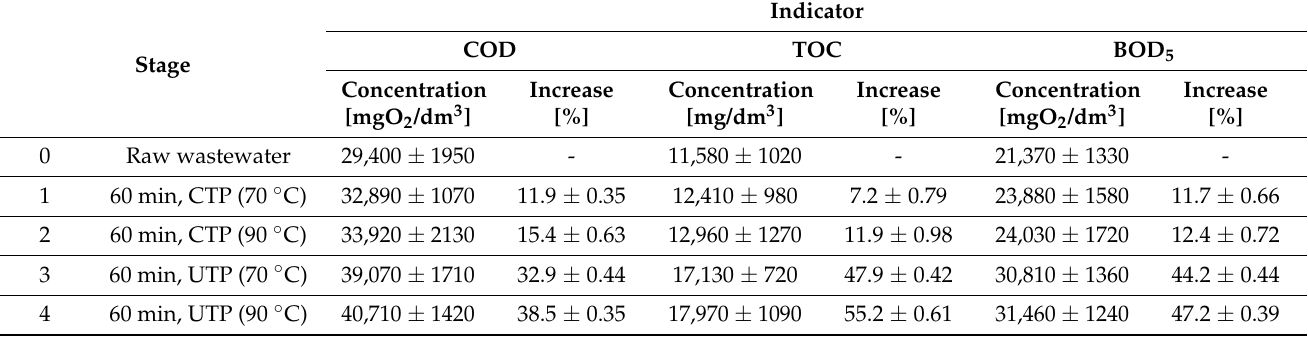
Table 3. Concentrations of organic compounds in the dissolved phased in individual experimental stages.